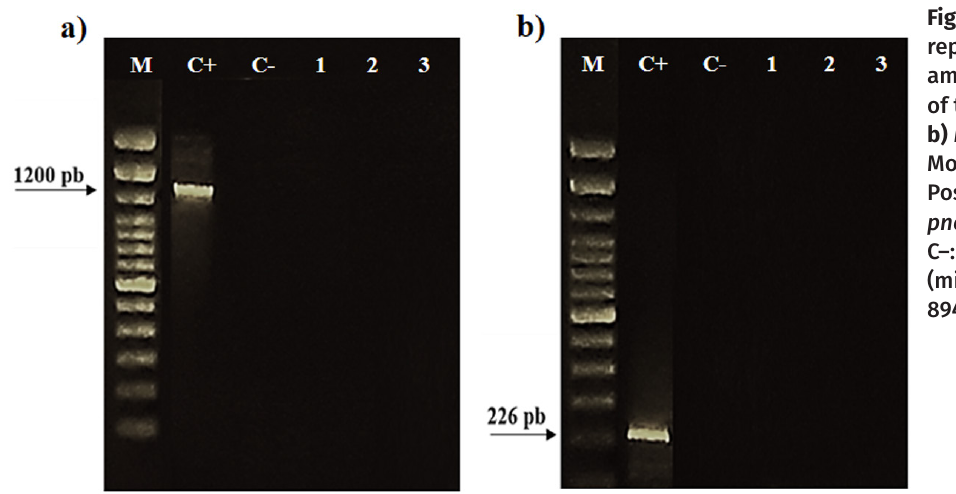
representative of the amplification products of the a) fimH and b) mrkD genes. M: Molecular marker;